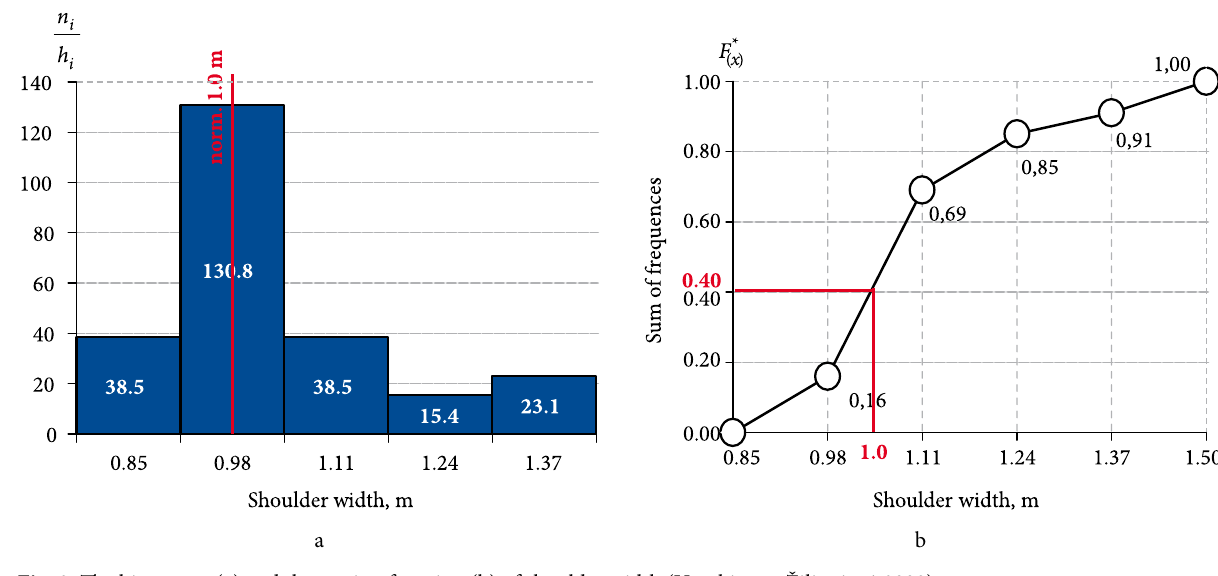
a b fig. 2. The histogram (a) and the section function (b) of shoulder width (Vorobjovas, Žilionienė 2008)